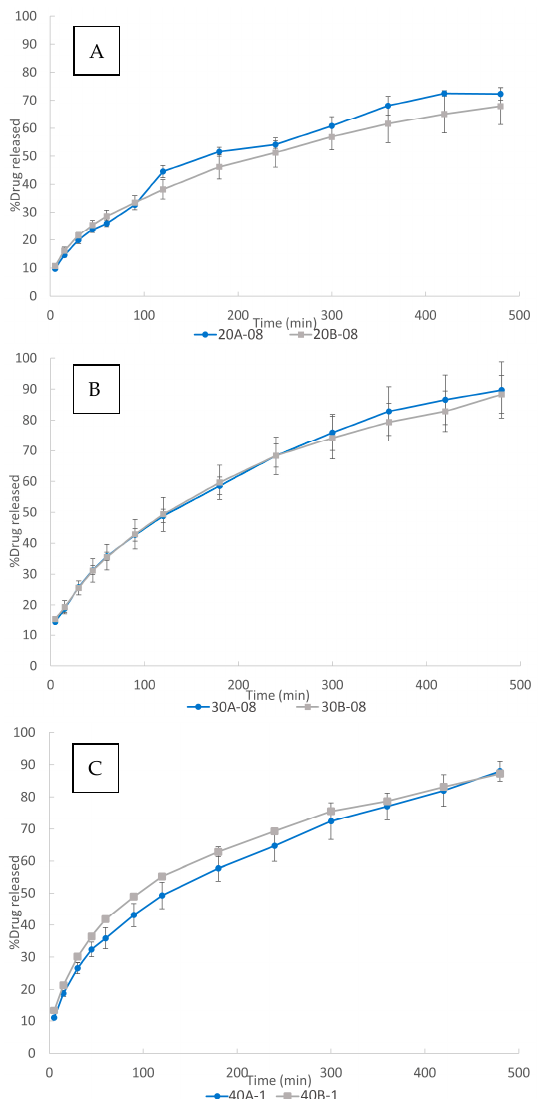
Figure 7. Effect of auxiliary excipients load on the vitro dissolution 3DP tablets: ( A ) 20% drug load, ( B ) 30% drug load, and ( C ) 40% drug load.